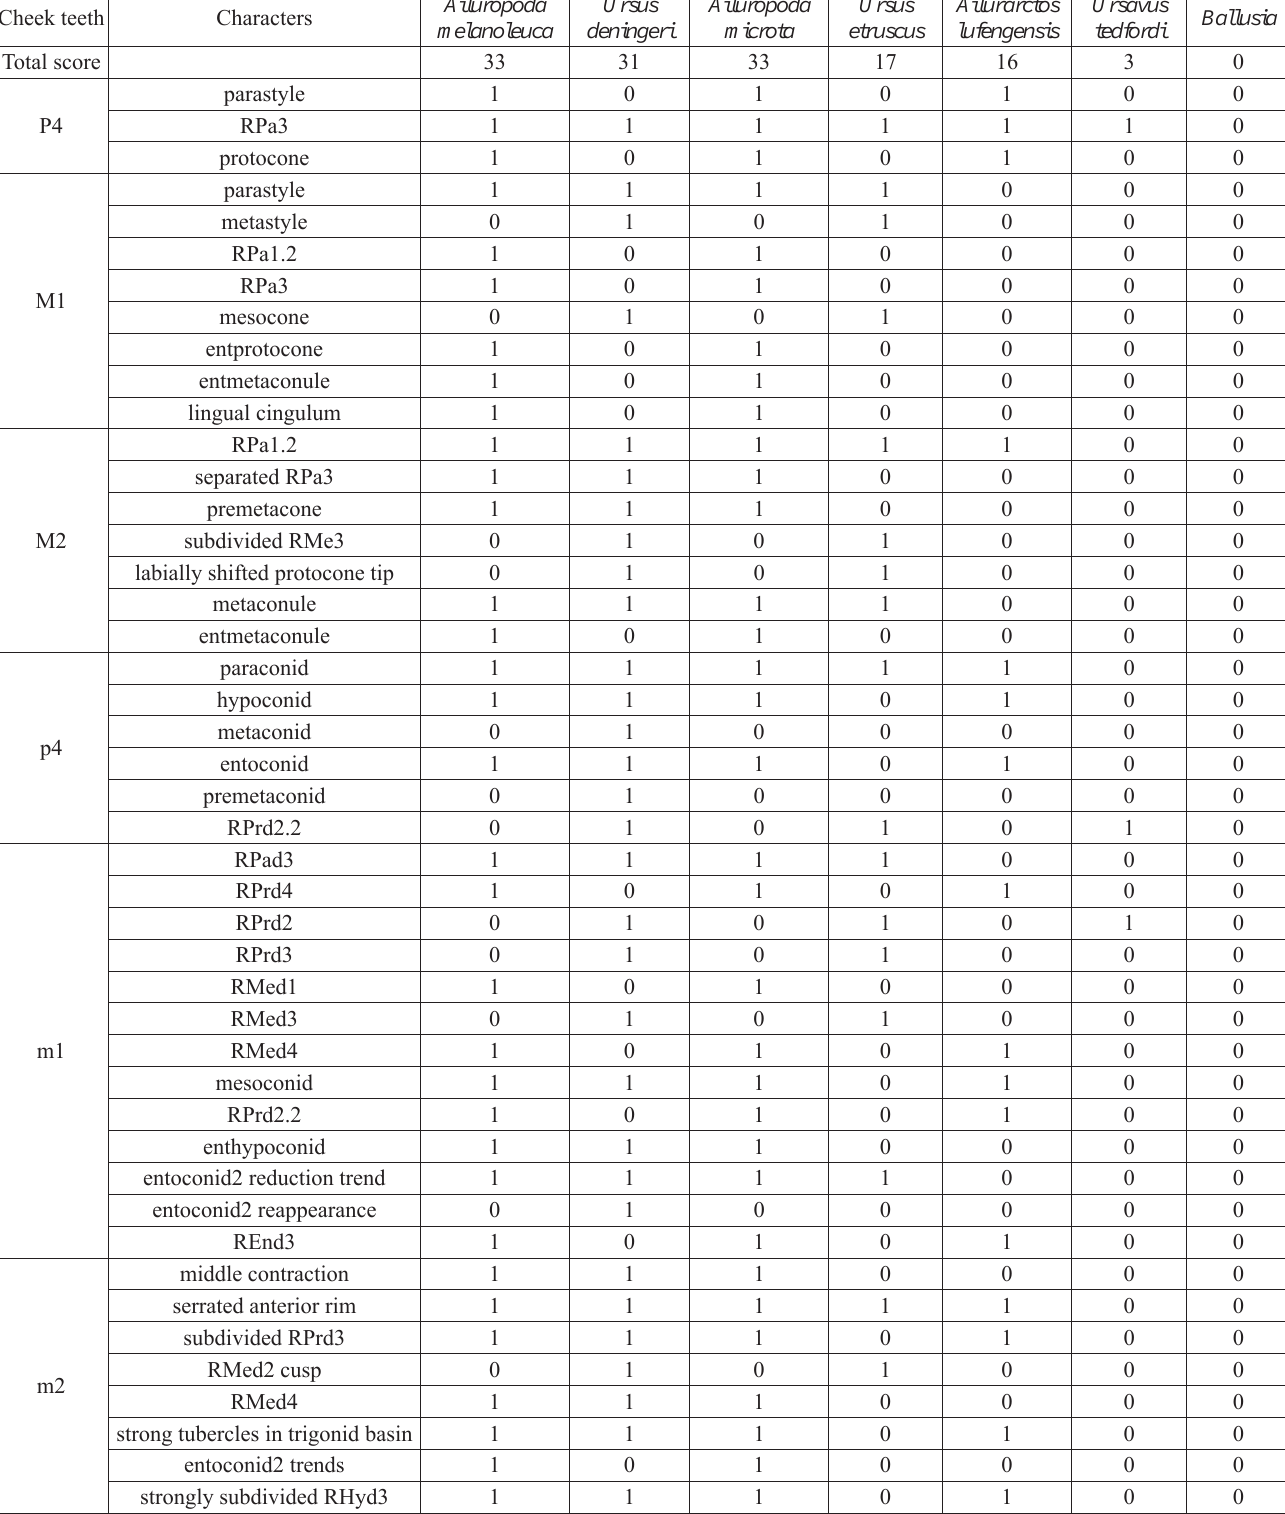
Table 2. Character matrix of giant panda, cave bear, and Ballusia lineages. Abbreviations: REnd3, medial ridge of entoconid; RHyd3, medial ridge of protoconid; RMed1, anterior ridge of metaconid; RMed2, posterior ridge of metaconid; RMe3/RMed3, medial ridge of metacone/metaconid; RMed4, postero-medial ridge of metaconid; RPa1.2, medial branch of anterior ridge of paracone; RPa3/RPad3, medial ridge of paracone/paraco- nid; RPrd2, posterior ridge of protoconid; RPrd2.2, medial branch of the posterior ridge of protoconid; RPrd3, postero-medial ridge of protoconid; RPrd4, postero-lateral ridge of